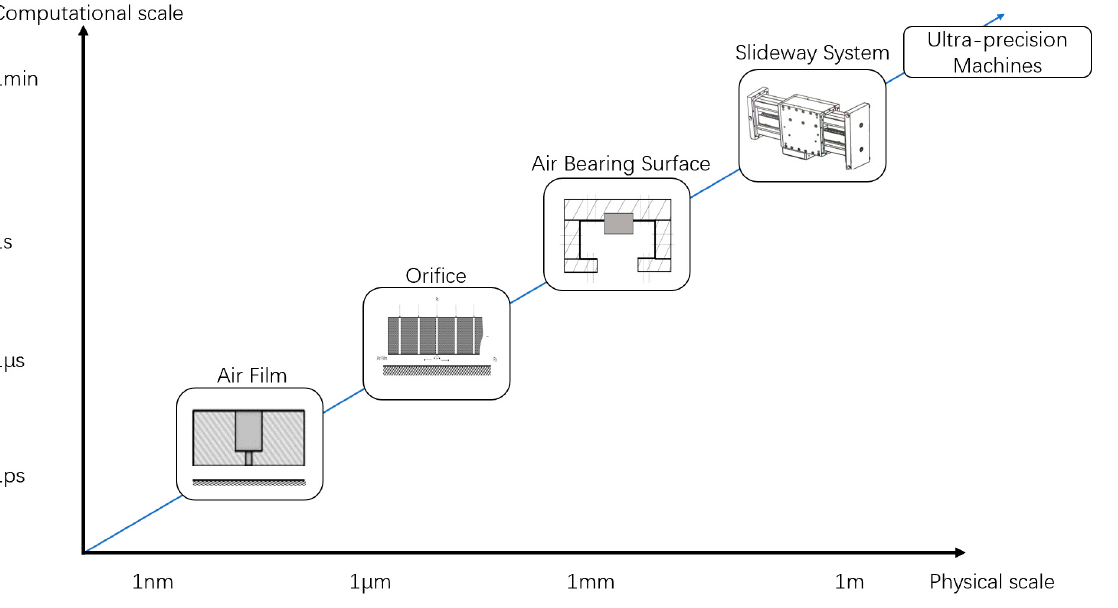
Figure 2. Different scales against the computational time.